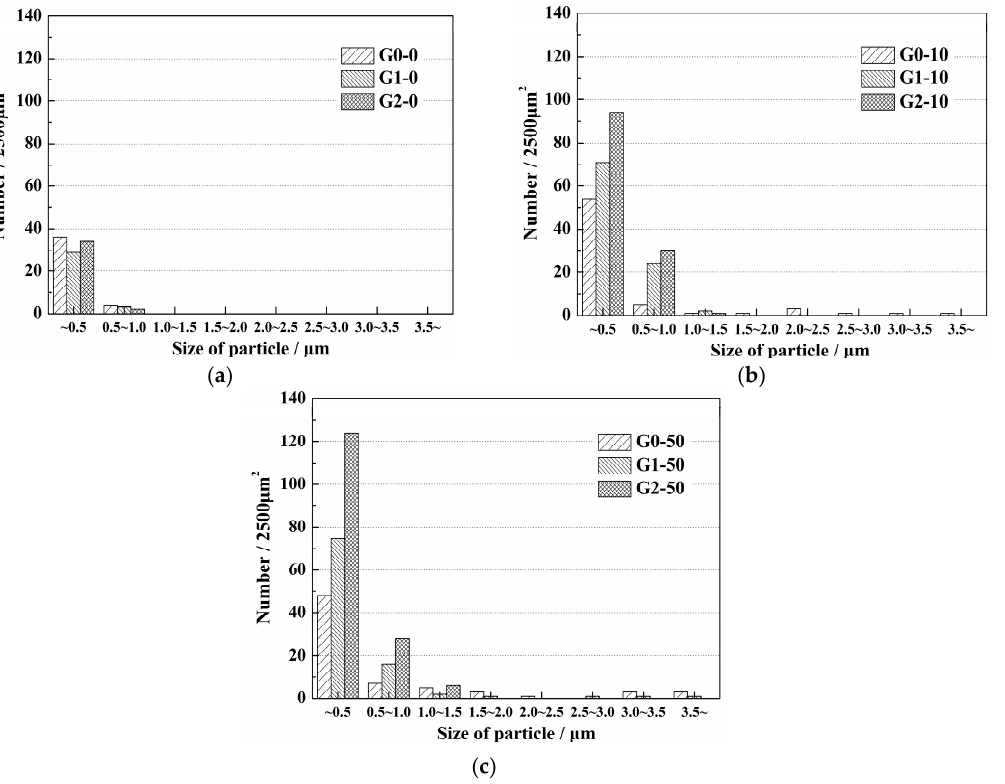
Figure 12. Size distributions of the particles which precipitated in the PPZ of diffusion couples G0, G1, and G2 before and after heat treatment at 1473 K: ( a ) before heat treatment (after oxide pre-melting experiment); ( b ) after heat treatment for 10 h; ( c ) after heat treatment for 50 h.